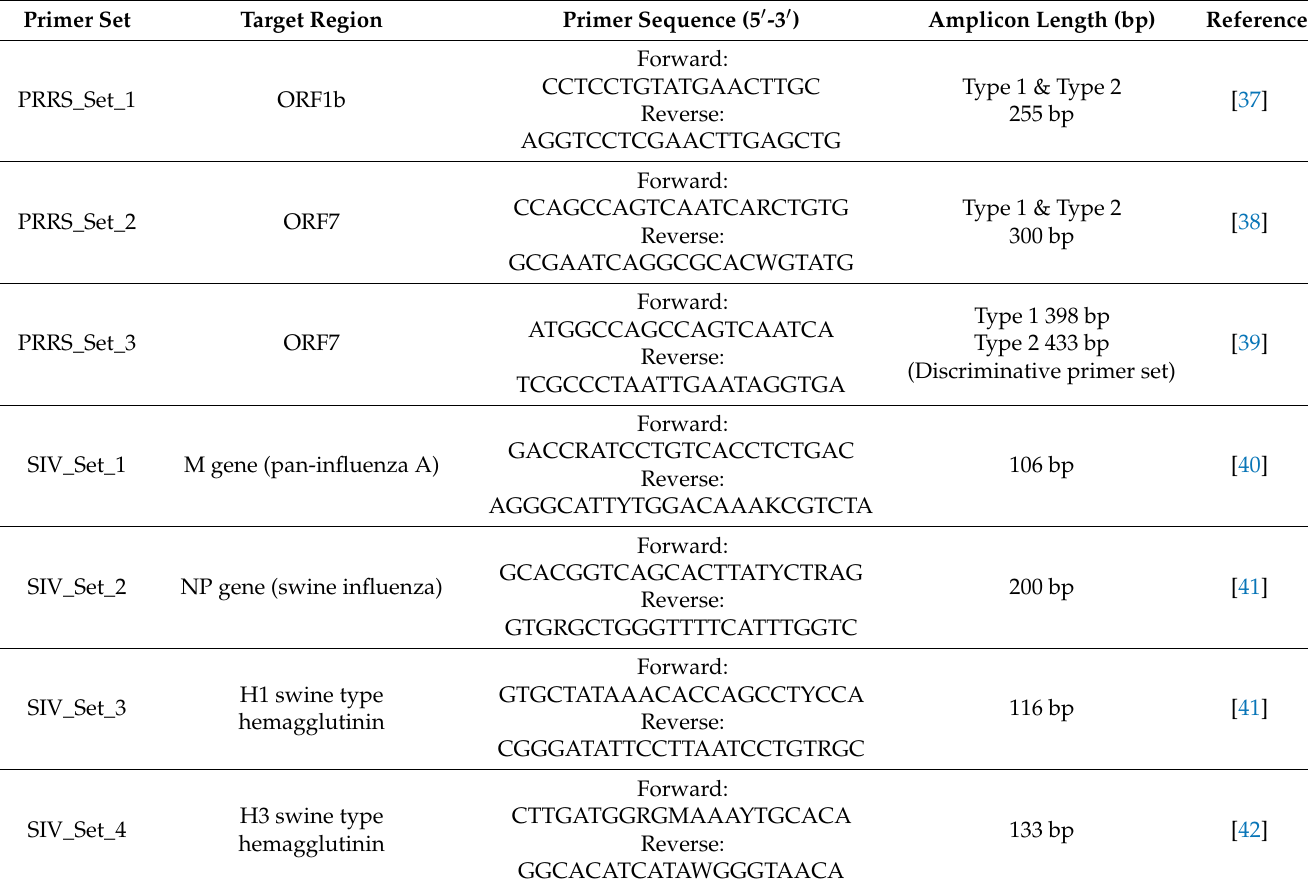
Table 1. Primer sets used in conventional PCR for the detection of PRRSV and SIV. Primer Set Target